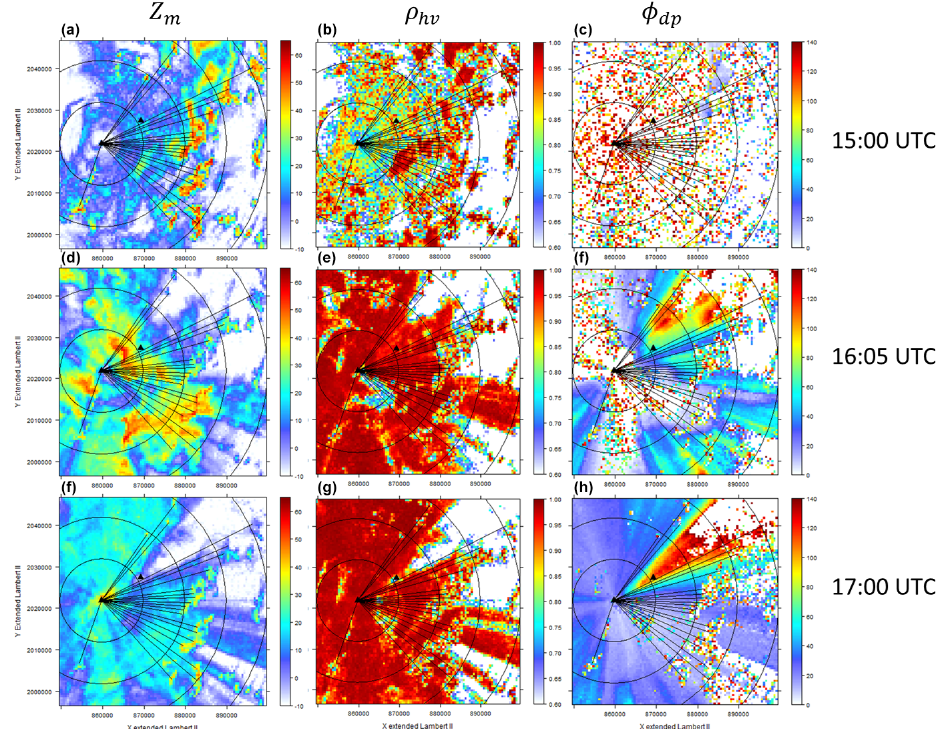
Figure 2. Examples of 0 ◦ elevation PPIs of measured reflectivity (a, d, f) , co-polar correlation coefficient (b, e, g) and total differential phase shift (c, f, h) taken before (a, b, c) and at two moments with intense precipitation ( d – h ) during the 21 July 2017 convective event. As in Fig. 1, the circular range markers of the Moucherotte mountain radar are spaced by